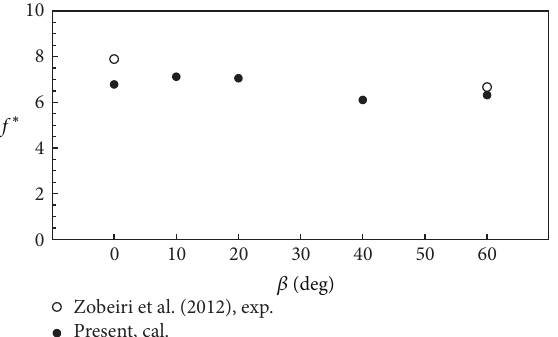
Figure 7: Shedding frequency of vortices from the different beveled trailing edges for Re = 10 6 . The experimental data by Zobeiri et al. [11] were derived from LDV measurements, and the approximate shedding frequency, as read from their figure, is normalized by the chord length and the undisturbed flow velocity.